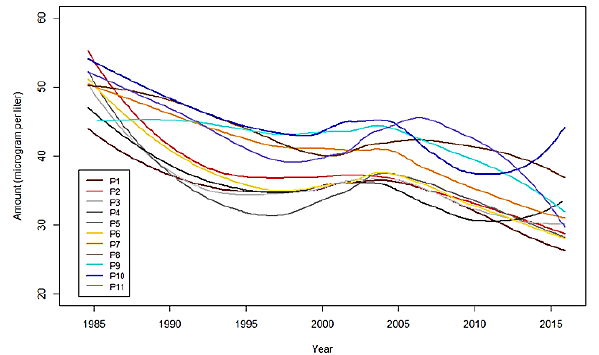
Figure 4. Temporal change of the estimated chlorophyll-a amount at the eleven sample